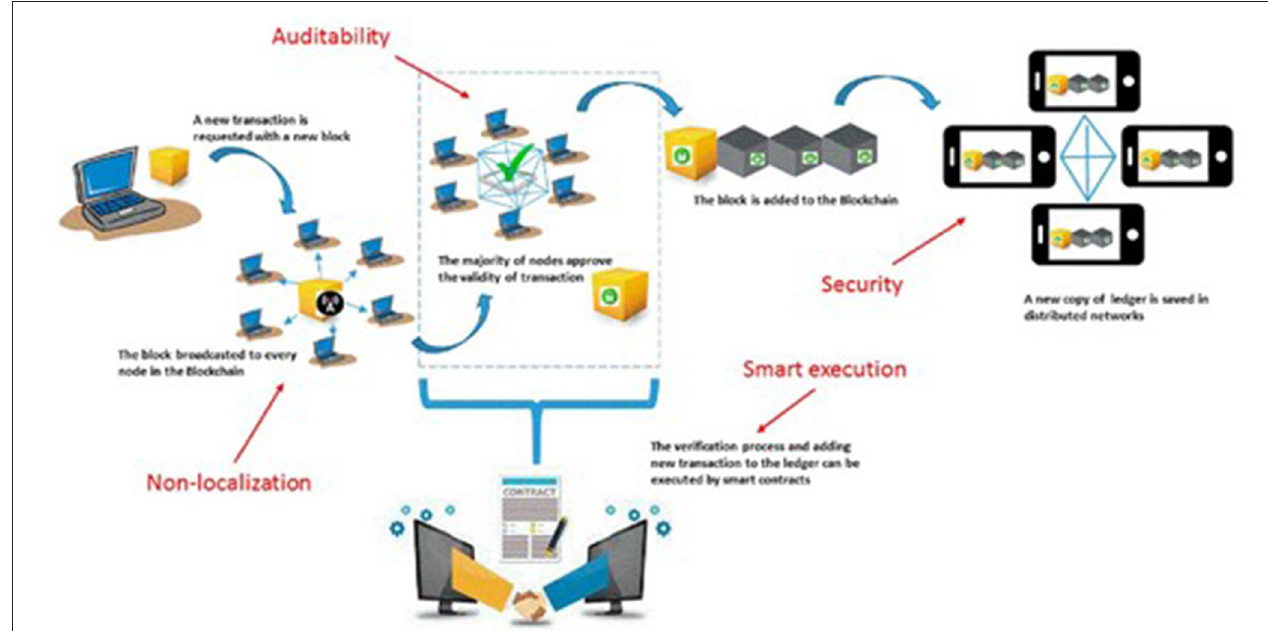
FIGURE 1 | Steps in blockchain information and transactions (Saberi et al.,